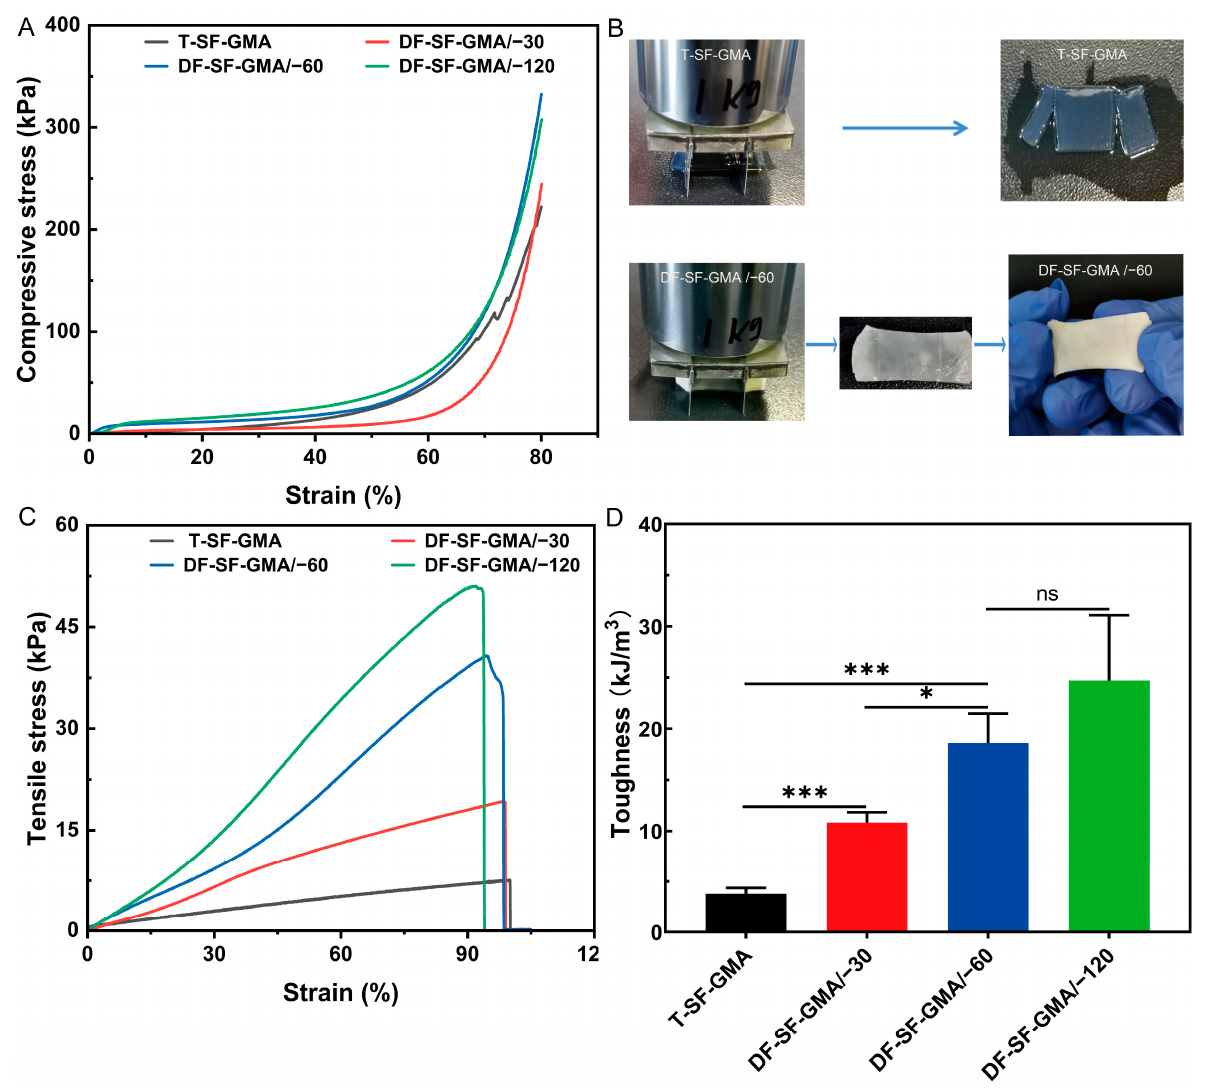
Figure 4. Physical properties of the DF-SF-GMA hydrogels. ( A ) Compression test for the T-SF-GMA and DF-SF-GMA hydrogels with varied freezing temperatures. ( B ) The T-SF-GMA and DF-SF- GMA/ − 60 were cut and compressed by a 1 kg weight for 1 min. The DF-SF-GMA/ − 60 hydrogel was still intact after removing the weight. ( C ) Tensile test for the SF-GMA hydrogels. ( D ) Toughness of the T-SF-GMA and DF-SF-GMA hydrogels (* p < 0.05; *** p < 0.001, n = 3).